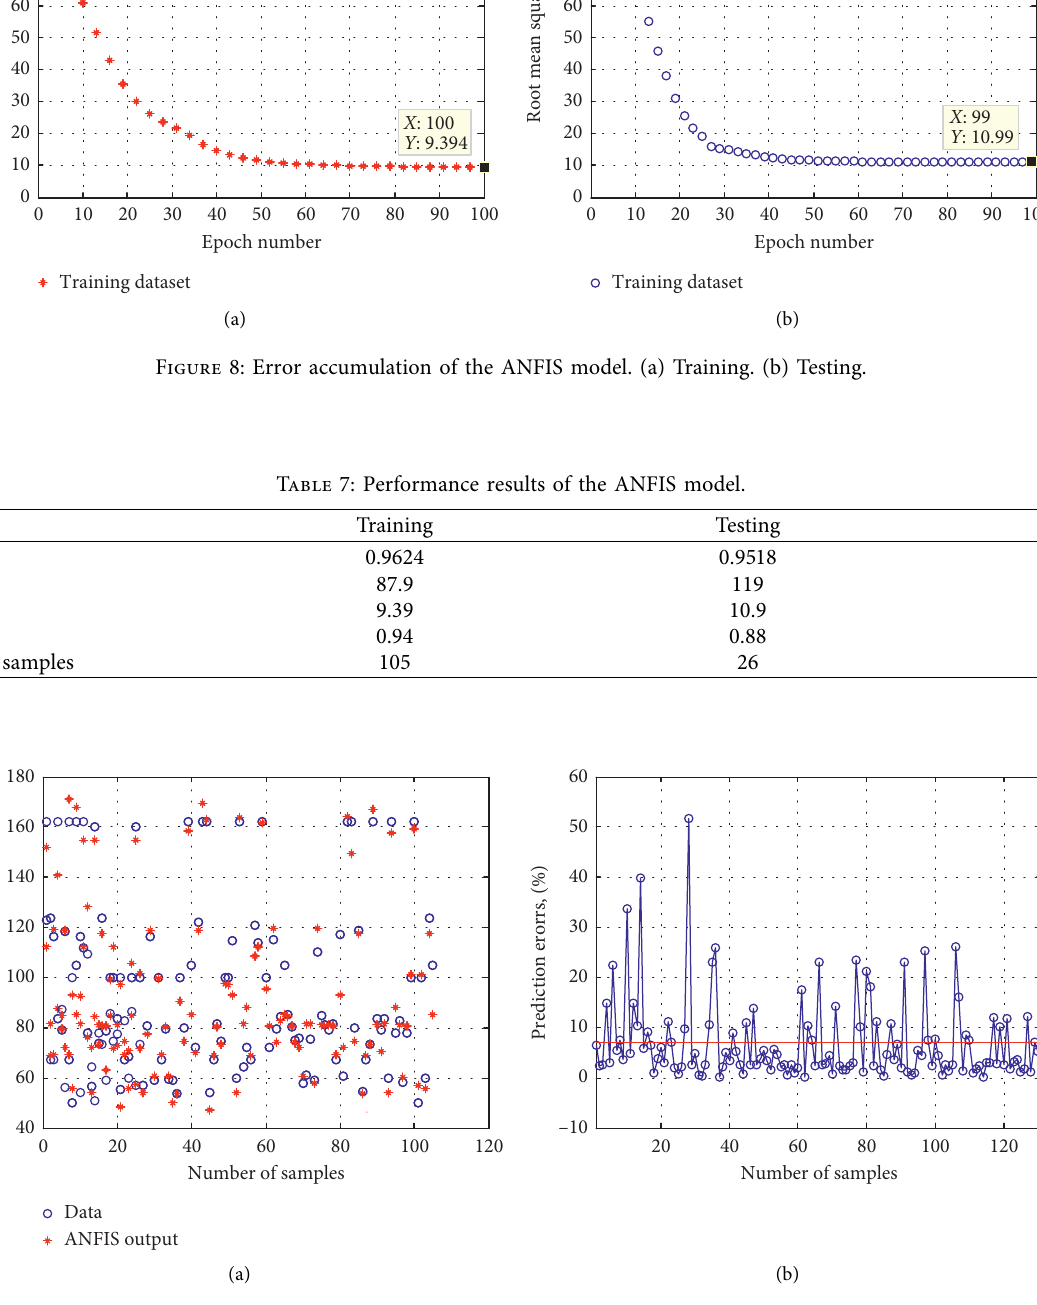
Figure 9: Performance of the ANFIS model. (a) Outputs versus inputs. (b) Absolute prediction